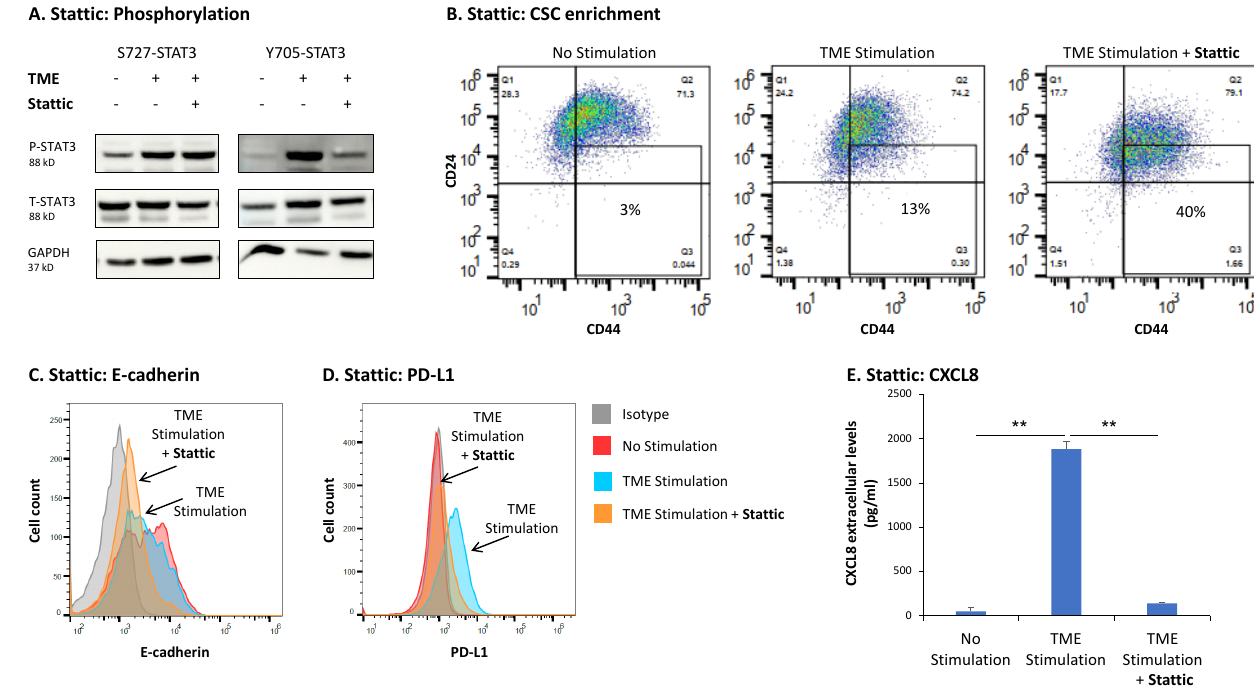
Figure 5. Upon TME Stimulation, the STAT3 inhibitor stattic leads to up-regulation of intrinsic pro- metastatic properties and to down-regulation of TME-related pro-metastatic traits of HR+/HER2 − breast cancer cells: MCF-7 cells were exposed to TME Stimulation (TME; concentrations as described in Figure 1) or treated by a vehicle control (“No Stimulation”). Two h prior to stimulation and also during stimulation, the cells were incubated with STAT3 inhibitor stattic (5 µ M, conventionally used concentration) or its vehicle. ( A ) The effect of stattic on S727-STAT3 (after 15 min of TME Stimulation, based on the findings of Figure 4B1) and Y705-STAT3 phosphorylation (after 96 h of TME Stimulation, based on the findings of Figure 4B2), were determined by WB analyses. ( B – E ) Functional effects of stattic, determined after 96 h of TME Stimulation, as described in Figure 1. In all panels, the results are from a representative experiment of n ≥ 3, showing similar results. ** p < 0.01. Results obtained from similar studies of CSC enrichment in T47D cells are demonstrated in Figure S1A. The uncropped blots are shown in Figure